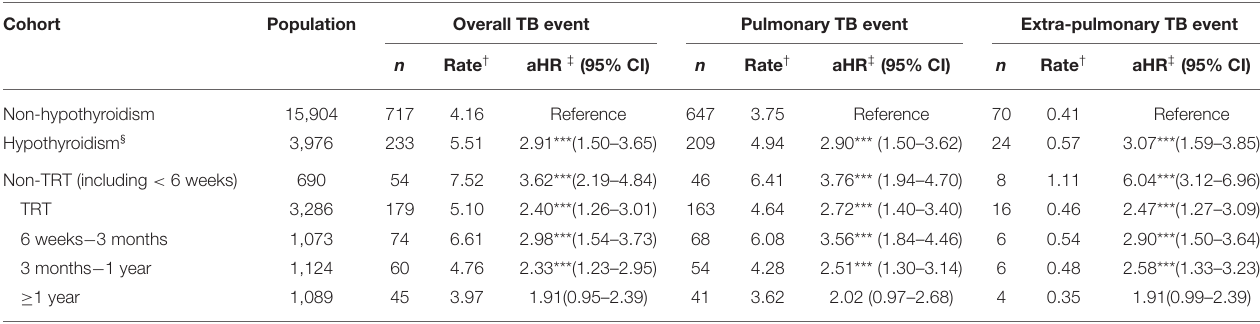
TABLE 4 | Adjusted hazard ratios of developing TB in hypothyroidism cohort (purpose